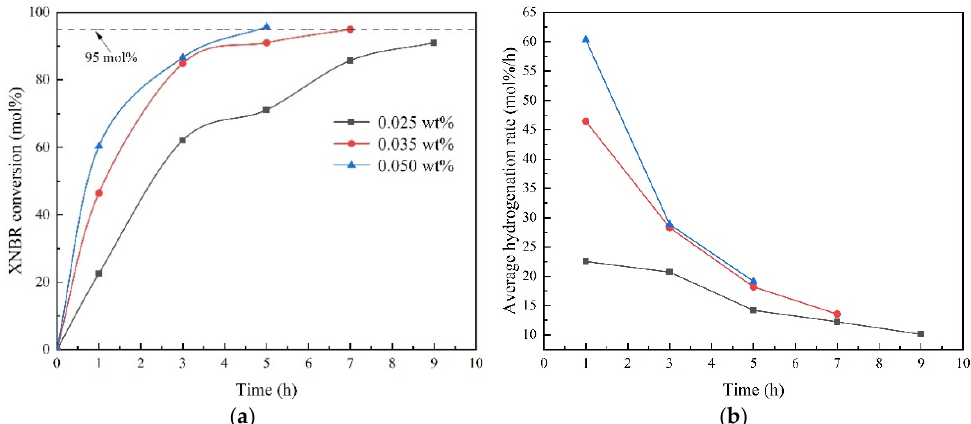
Figure 6. The XNBR conversion ( a ) and average hydrogenation ( b ) rates recorded with different catalyst dosages.